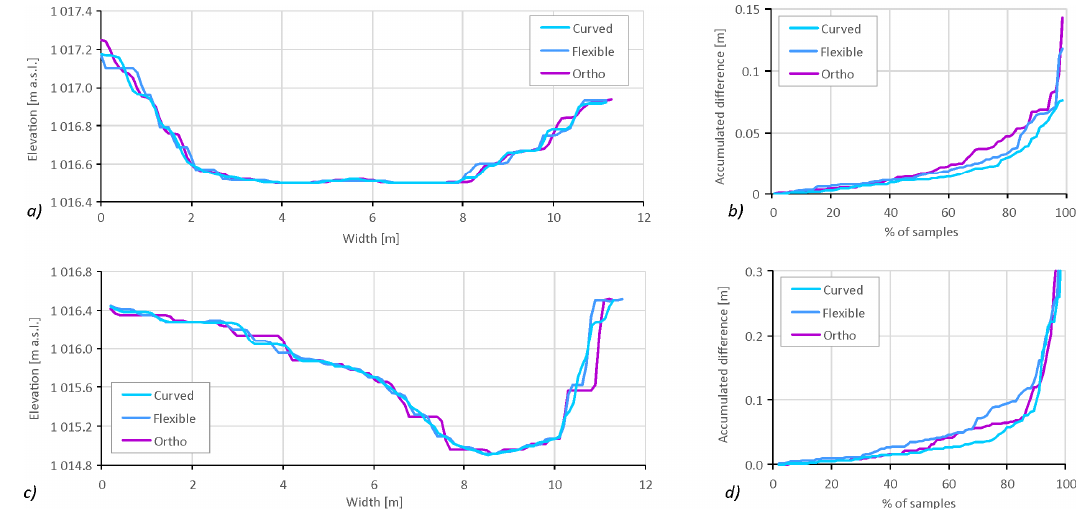
Figure 9. Cross-sections of the model domain derived from three different types of schematization—the flexible mesh (Flexible), orthogonal grid (Ortho) and curved grid (Curved). ( a ) Cross-profile A with the lowest differences along the analyzed segment; ( b ) accumulated difference at the bank of profile A; ( c ) cross-profile B with the greatest differences among schematizations; ( d ) accumulated difference at the bank of profile B.